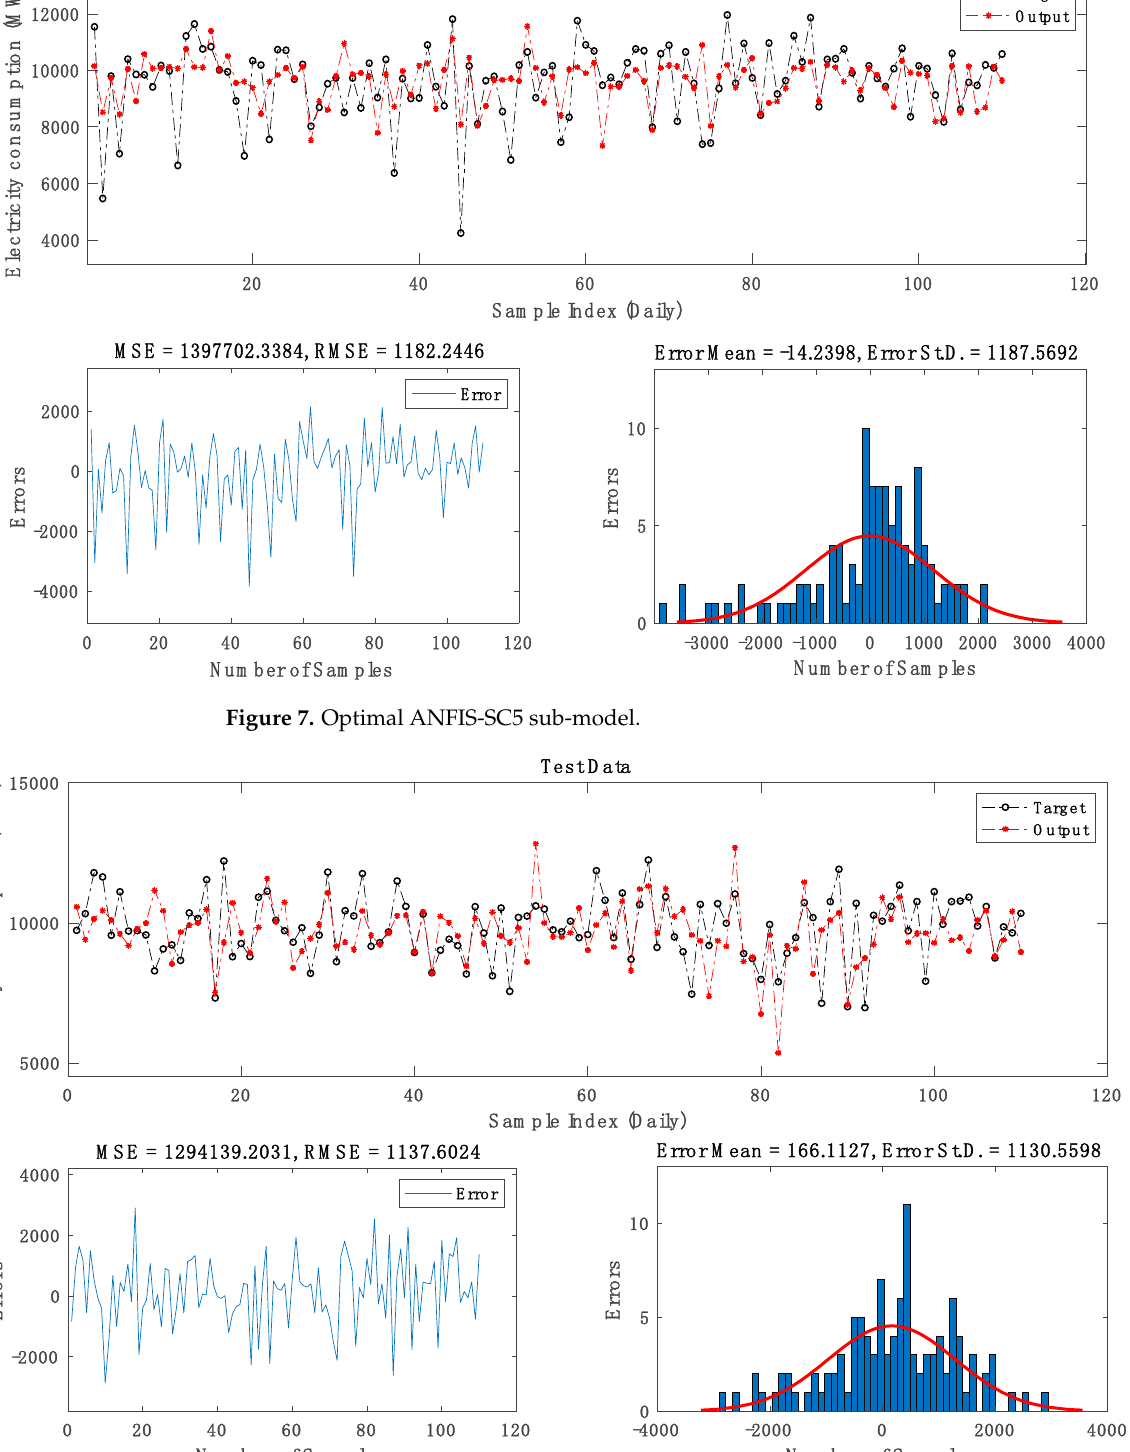
Figure 8. Optimal ANFIS-FCM3 sub-model. Table 8. Comparison of the sub-optimal model with previous works, involving energy usage pre- diction.